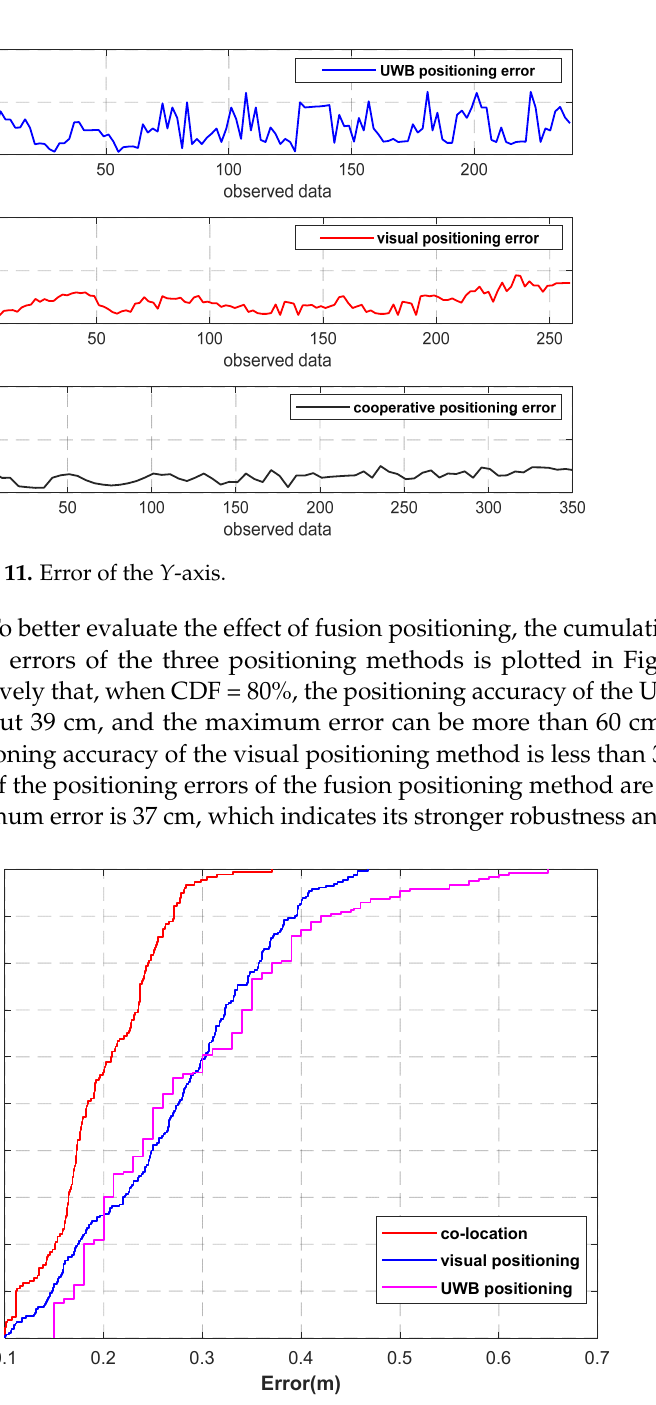
Figure 12. Error probability distribution.